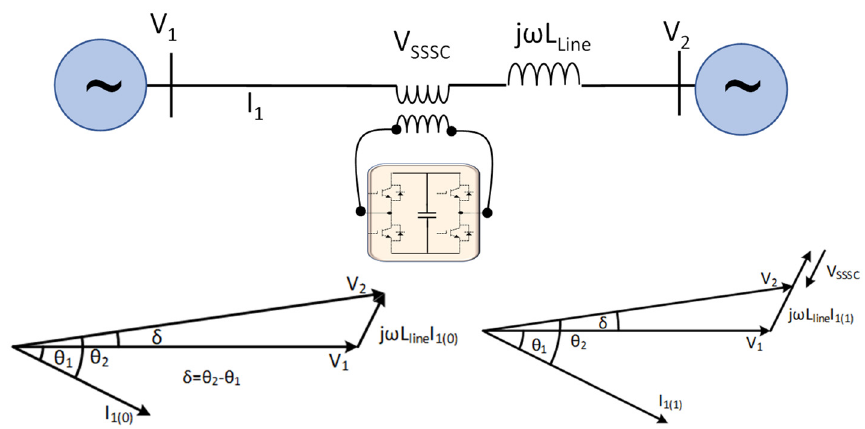
Figure 3. Basic operation of SSSC with phasor diagram.